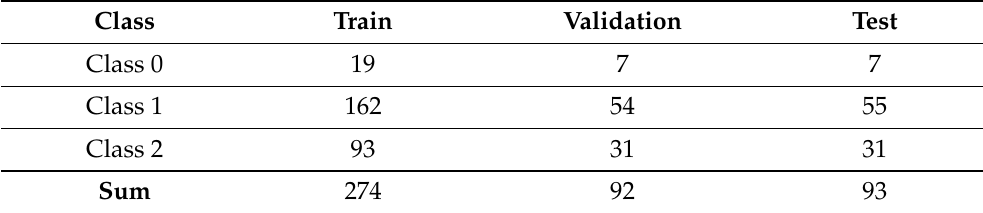
Table 2. Number of observations in the dataset and its distribution between